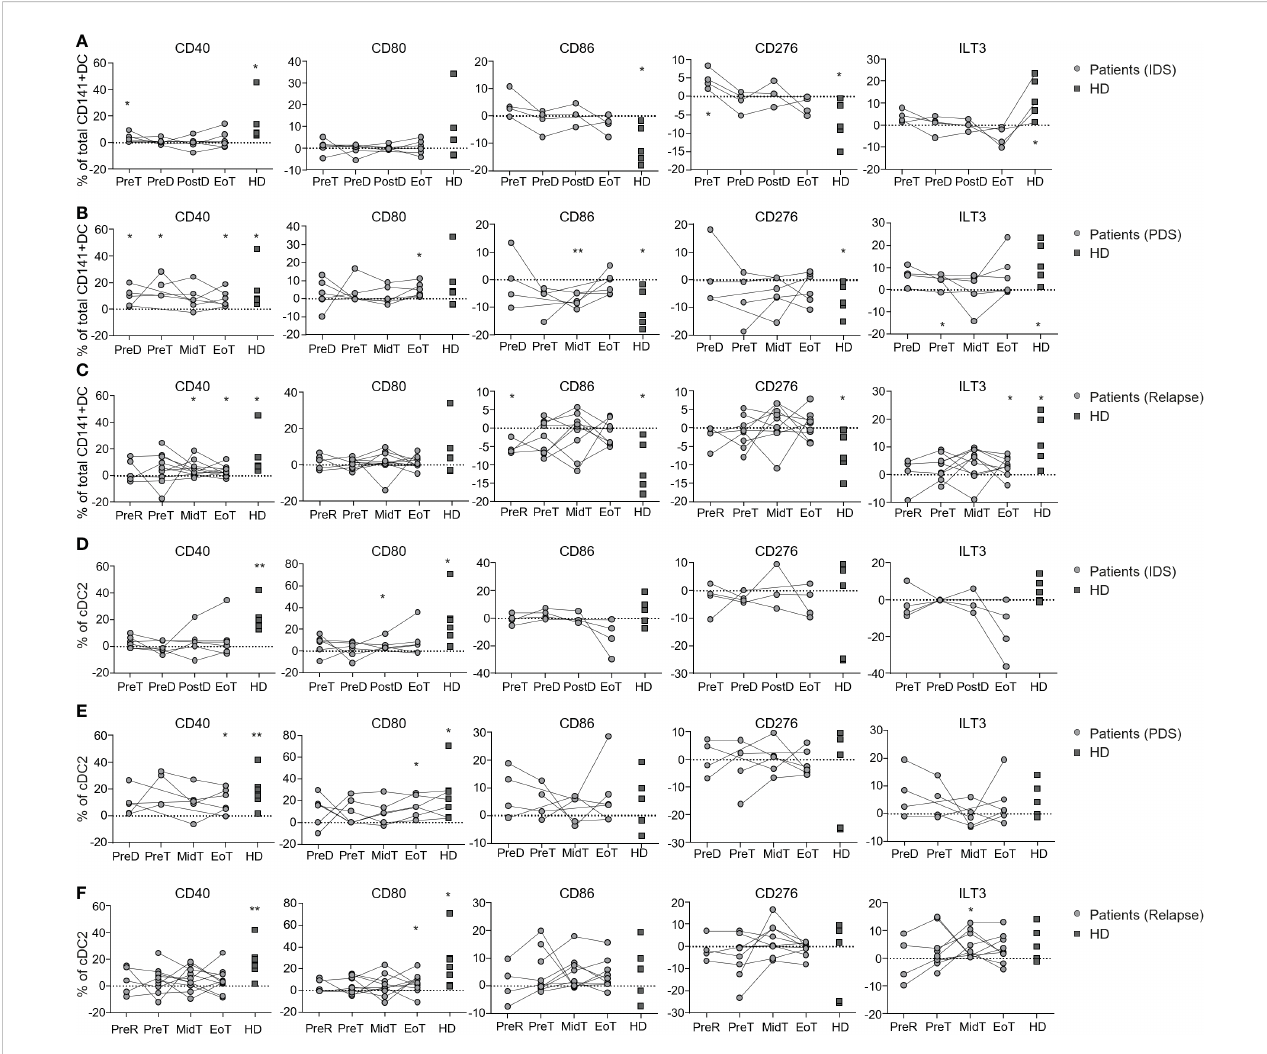
FIGURE 4 Longitudinal monitoring of the capacity to respond to Poly(I:C) in vitro by DC populations in patients with OvC and in HD. Cumulative data of the variation (frequency subtraction from the unstimulated cells) in the expression of CD40, CD80, CD86, CD276 and ILT3 by total CD141 + DC after Poly(I:C) stimulation in HD (dark grey squares) and in patients (grey dots) belonging to (A) IDS, (B) PDS, or (C) relapse group. Cumulative data of the variation (frequency subtraction from the unstimulated cells) in the expression of CD40, CD80 CD86, CD276 and ILT3 by cDC2 after Poly(I:C) stimulation in HD (dark grey squares) and in patients (grey dots) belonging to (D) IDS, (E) PDS or, (F) relapse group. * p < 0.05, ** p < 0.01. One-way ANOVA tests followed by pairwise Dunn ’ s tests. Statistical differences refer to comparison with the unstimulated